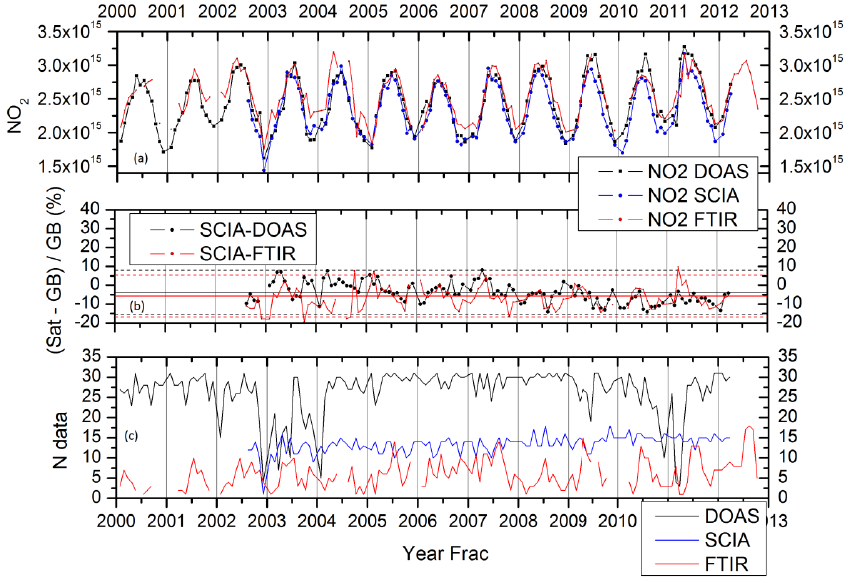
Figure 8. Same as Fig. 5 but for SCIAMACHY vs. DOAS and FTIR (only a.m. data). Note that the scale in the top plot is different from Fig.